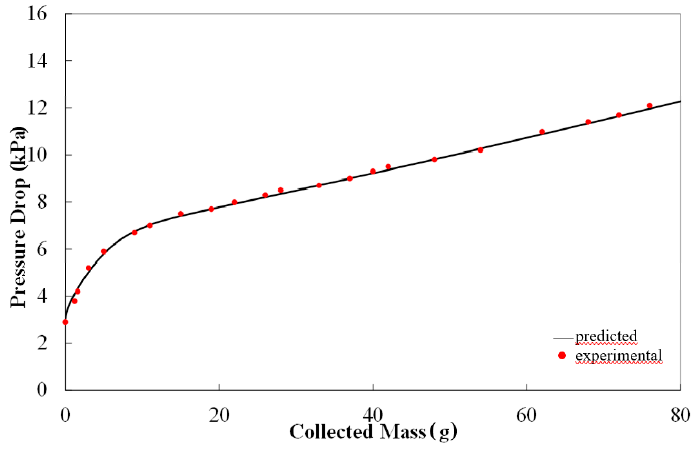
Figure 4. Pressure drop trend versus collected mass.